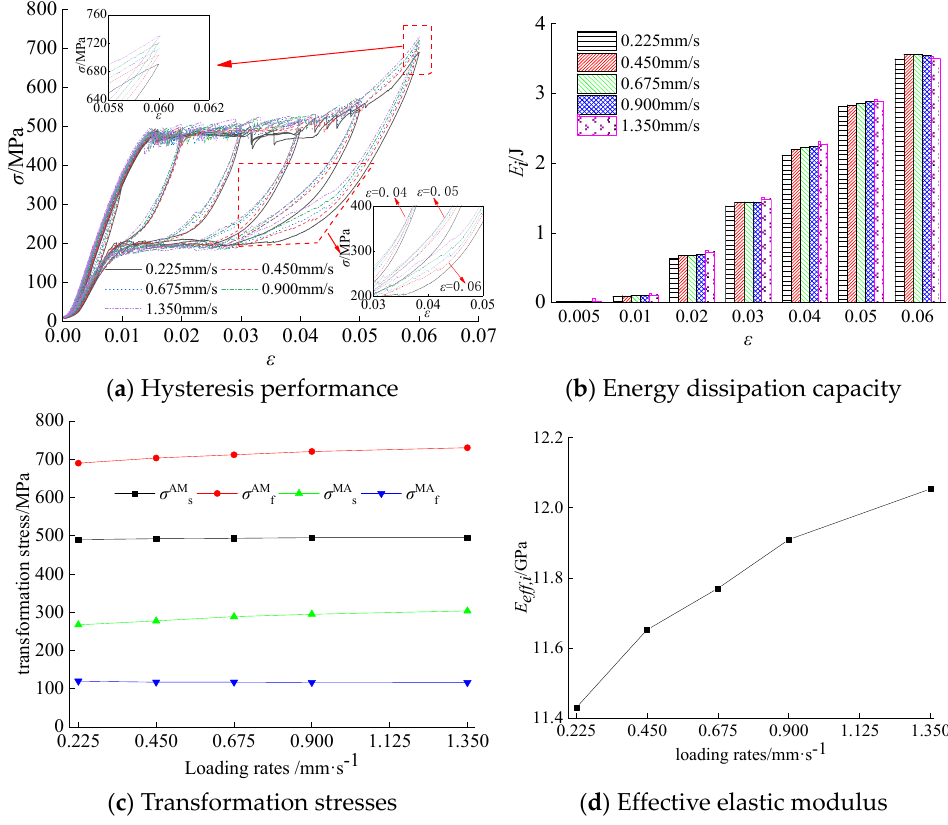
Figure 4. Effect of loading rate on the mechanical properties of the SMA wire.